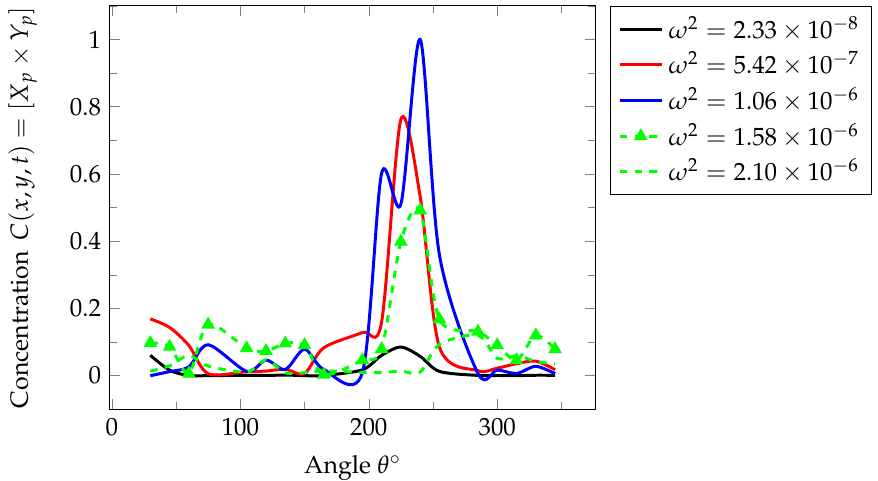
Figure 6. Concentration profile versus angle ( θ ◦ ) and varying separation constant ( ω 2